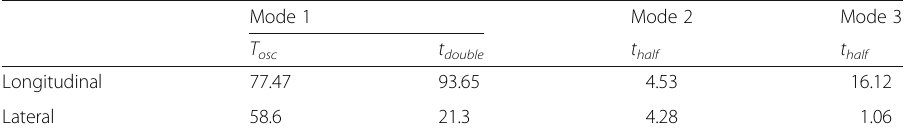
Table 8 Time constants of longitudinal and lateral